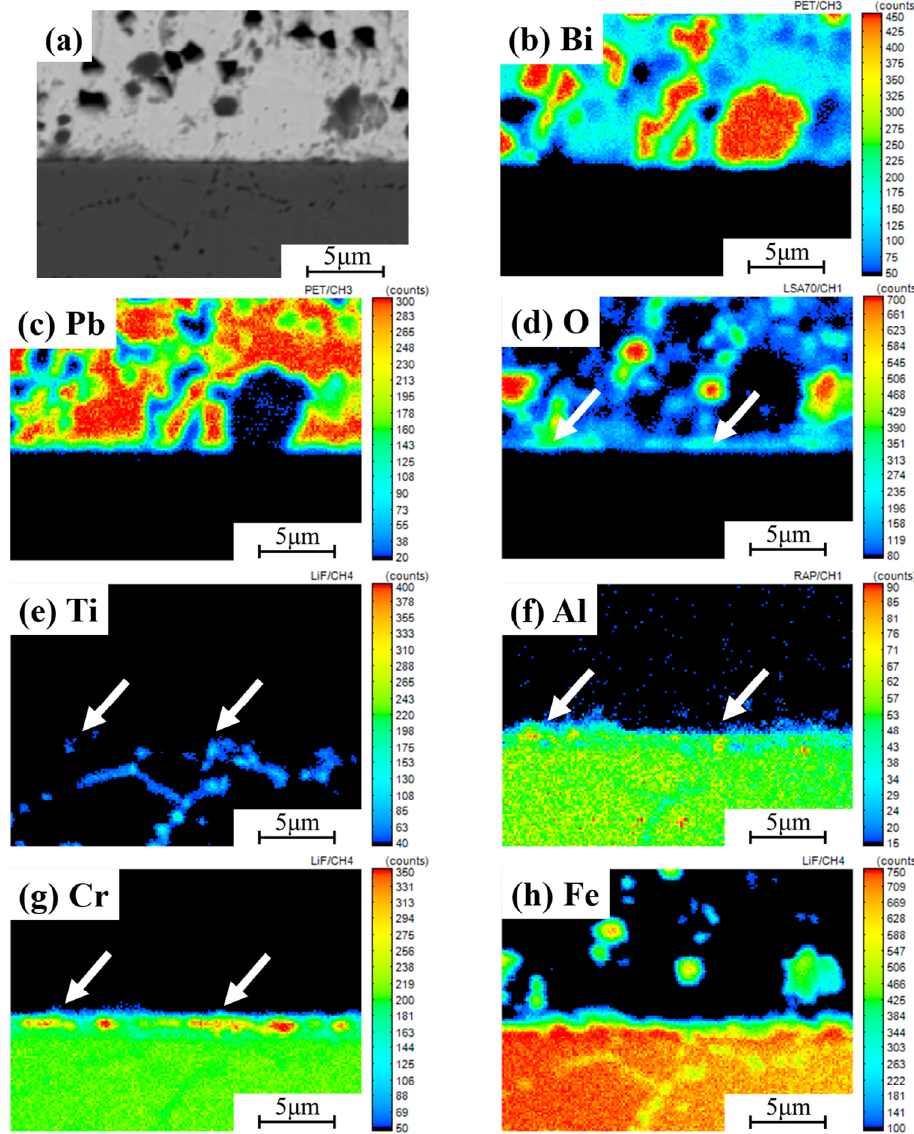
Figure 12. EPMA results of the 0.2 wt.% Y 2 O 3 coating cross-section after 1000 h LBE corrosion: ( a ) Image of tested area; ( b ) Bi; ( c ) Pb; ( d ) O; ( e ) Ti; ( f ) Al; ( g ) Cr; ( h ) Fe.